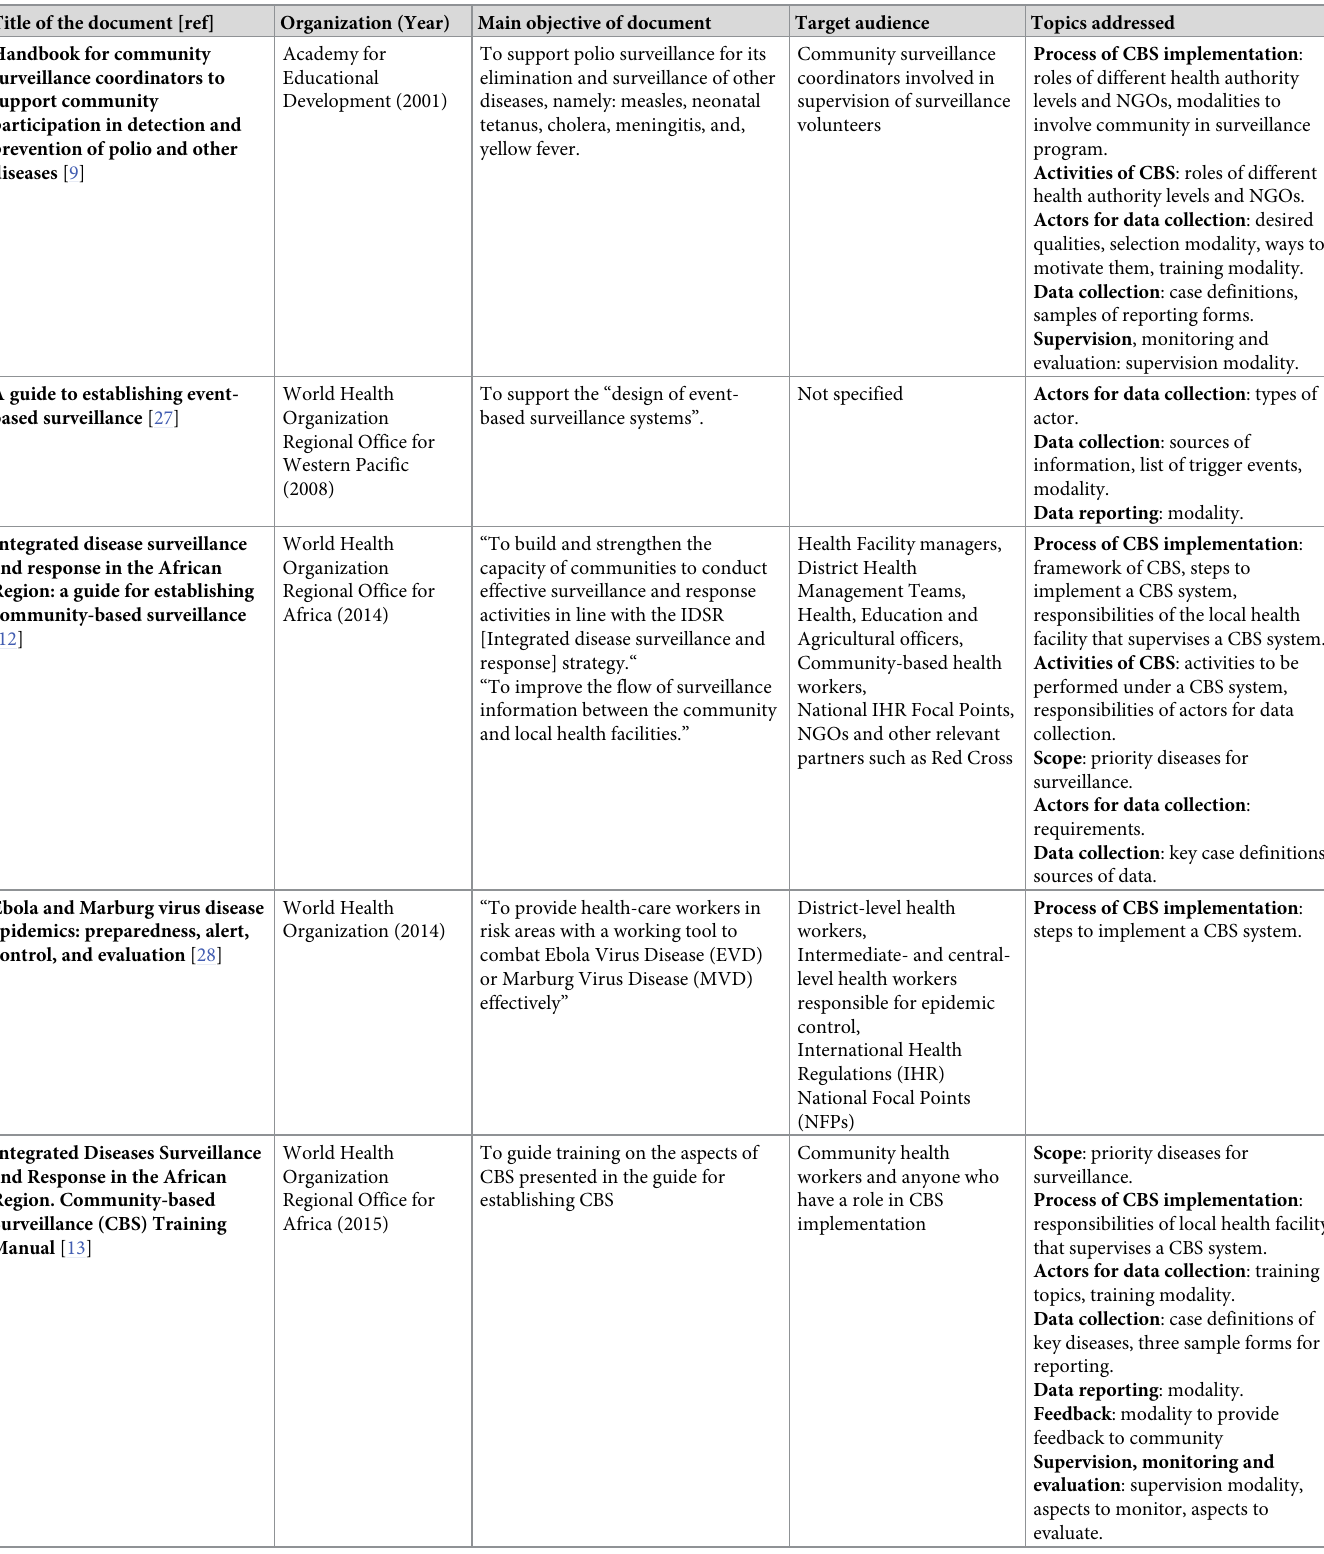
Table 2. Major guidance documents on